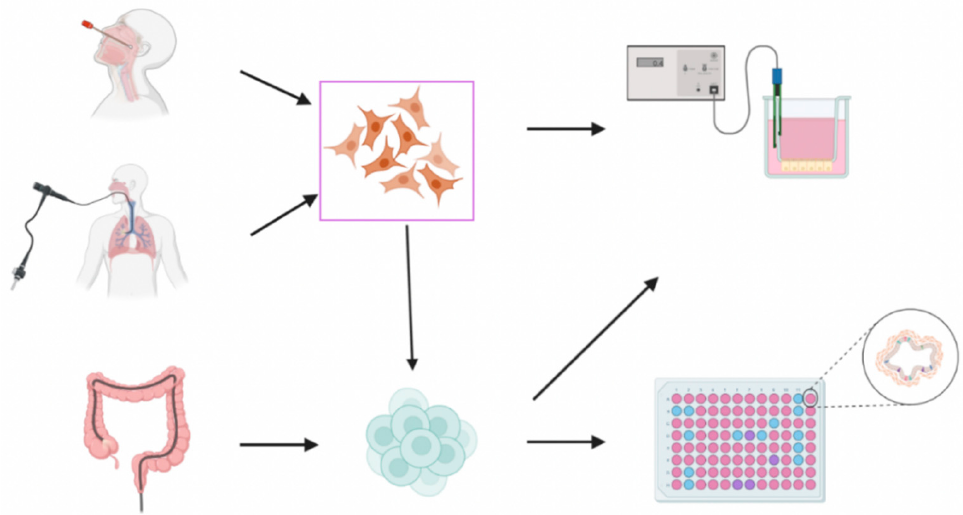
Figure 1. Overview of available strategies to generate patient-derived models. ( Top ) Well- differentiated airway epithelium cultures can be obtained from nasal or bronchial brushing and cultured at the air-liquid interface (ALI). The 2D ALI cultures could be used as a preclinical tool to test novel small molecules by electrophysiological studies. These cells can also be cultured in a 3D matrix to increase the throughput/scalability as airway organoids. ( Bottom ) The 3D intestinal organoids are obtained from rectal biopsy and could be used for high-throughput screening to investigate novel therapies. These organoids can also be grown in 2D monolayers to assess CFTR rescue and function by traditional electrophysiological measurements.